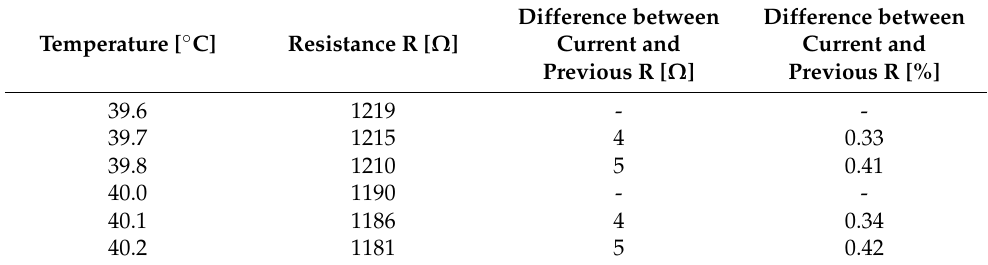
Table 1. Detailed thermistor values.